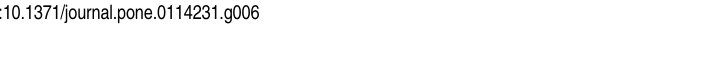
Figure 6. Effects of pretreatment with lidocaine on rocuronium onset